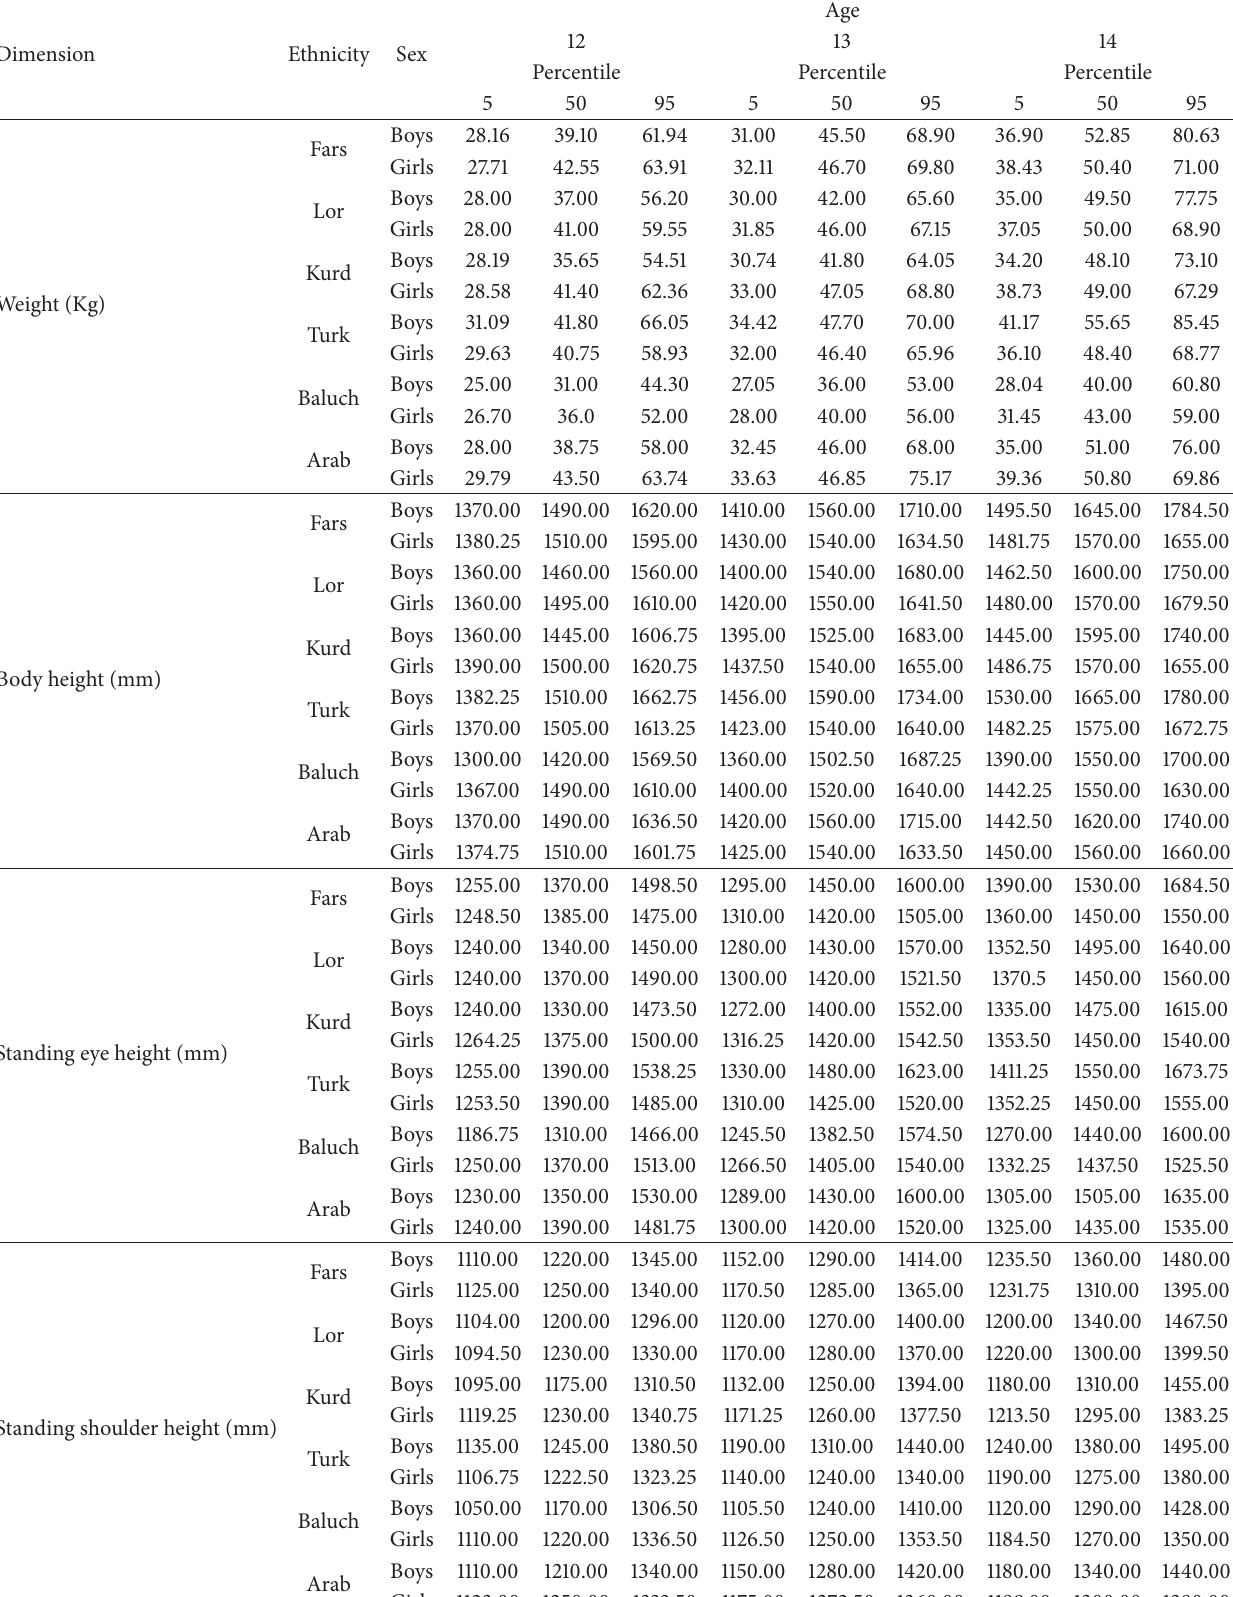
Table 4: Key percentiles of six anthropometric